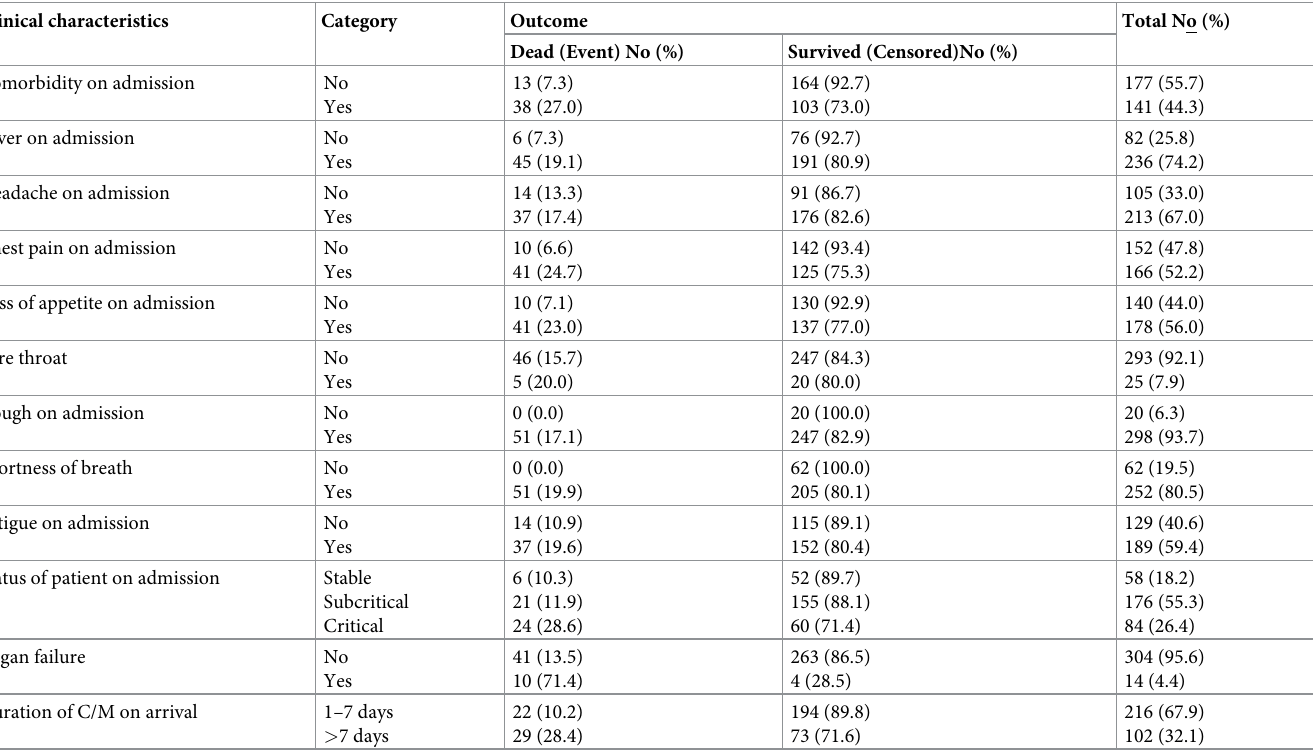
Table 2. Clinical characteristics of COVID-19 cases admitted to Wollega University Referral Hospital treatment center, Western Ethiopia. Clinical